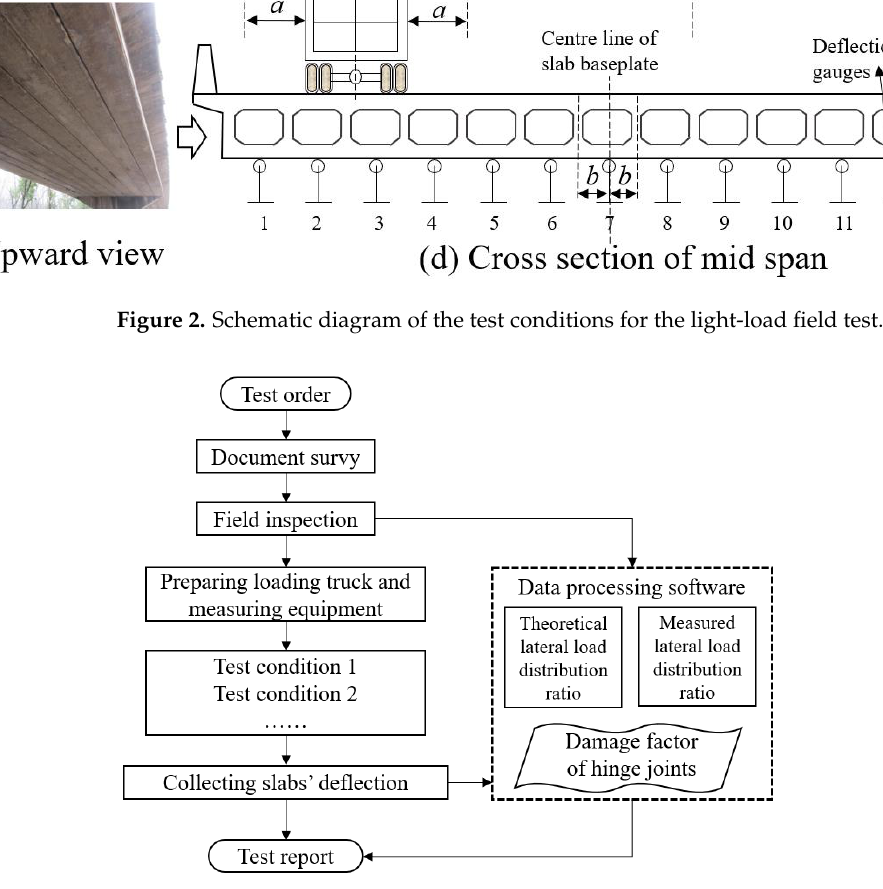
Figure 2. Schematic diagram of the test conditions for the light-load field test.